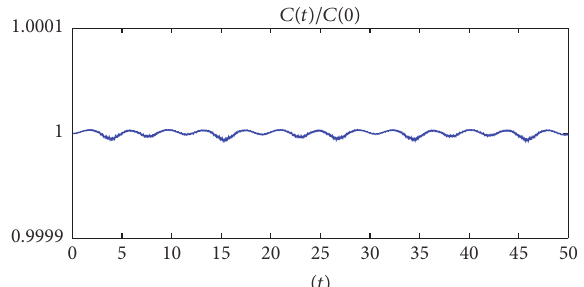
Figure 5: In this numerical experiment we see that the quantity 𝐶(𝑡) is close to 1, as long as time evolves. This shows that the numerical solver (57) conserves approximately the 𝐿 2 -norm of the function 𝑢(𝑥,𝑡) in system